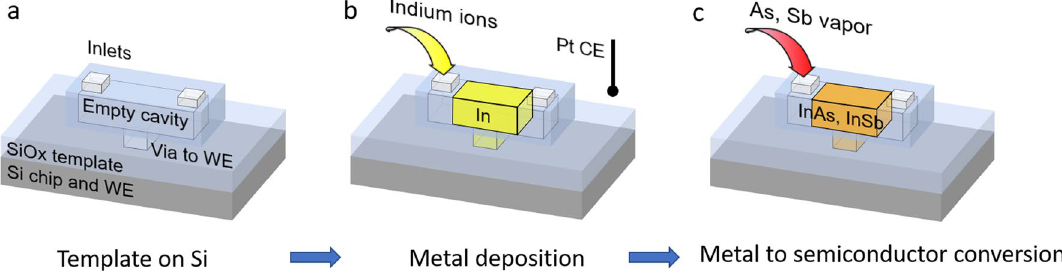
Fig. 1 Process flow for selective In-based semiconductor integration on Si. a 3D schematic of the template structure. The cavity structure contains inlet holes and a via to the substrate. b Indium is electrodeposited from an electrolyte into the cavity using the via to access the WE and a Pt electrode as CE. c The In-filled template is transferred and heated in a MOCVD reactor for V-element saturation. Here, the liquid In is converted into a crystalline semiconductor, that nucleates from the Si surface. WE working electrode, CE counter